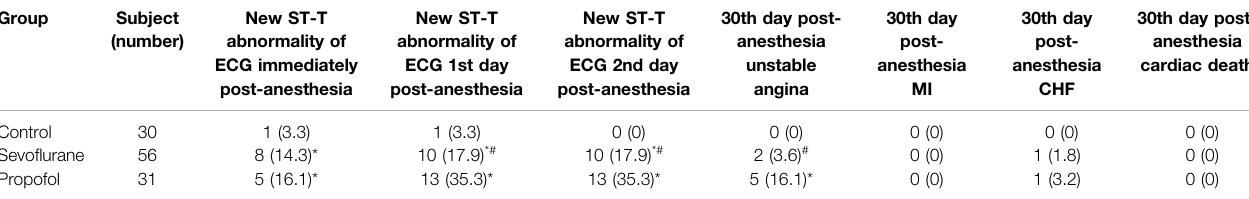
TABLE 3 | Post-anesthetic myocardial ischemia and cardiac events in the three groups